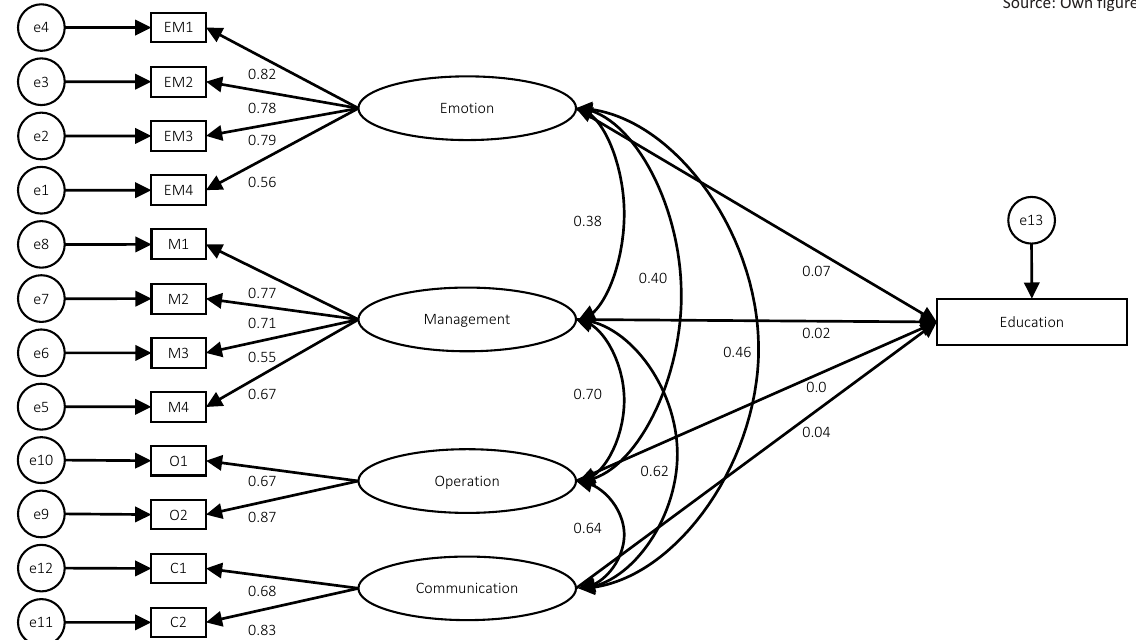
Figure 1. Possibility of learning soft skills in school